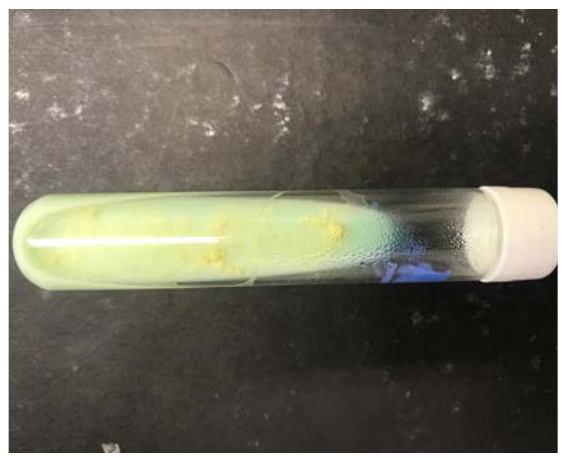
fIguRE 3 – Positive culture in lowenstein jensen medium positive for M. tuberculosis